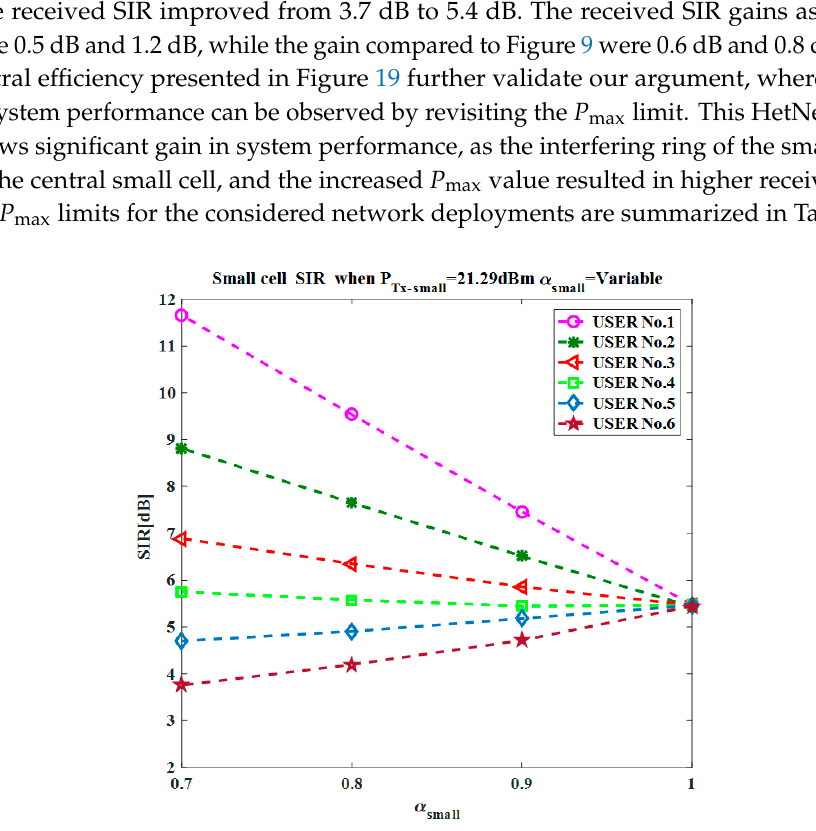
Figure 18. SIR as a function of α small in the HetNet deployment.